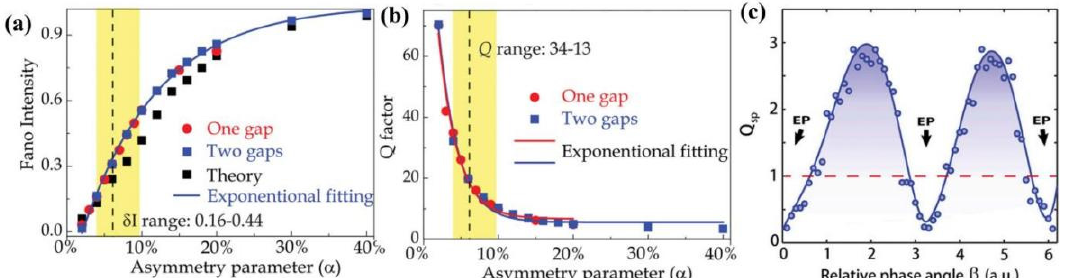
Figure 13. ( a ). Resonance strength of Fano versus structural asymmetry parameter. Adapted with permission from Ref. [162]. Copyright (2017), American Chemical Society. ( b ) Q factor of Fano resonance versus structural asymmetry parameter. ( c ) Effect on the splitting quality factor Q sp . Adapted with permission from Ref. [46]. Table 2. Examples of EP biosensors.